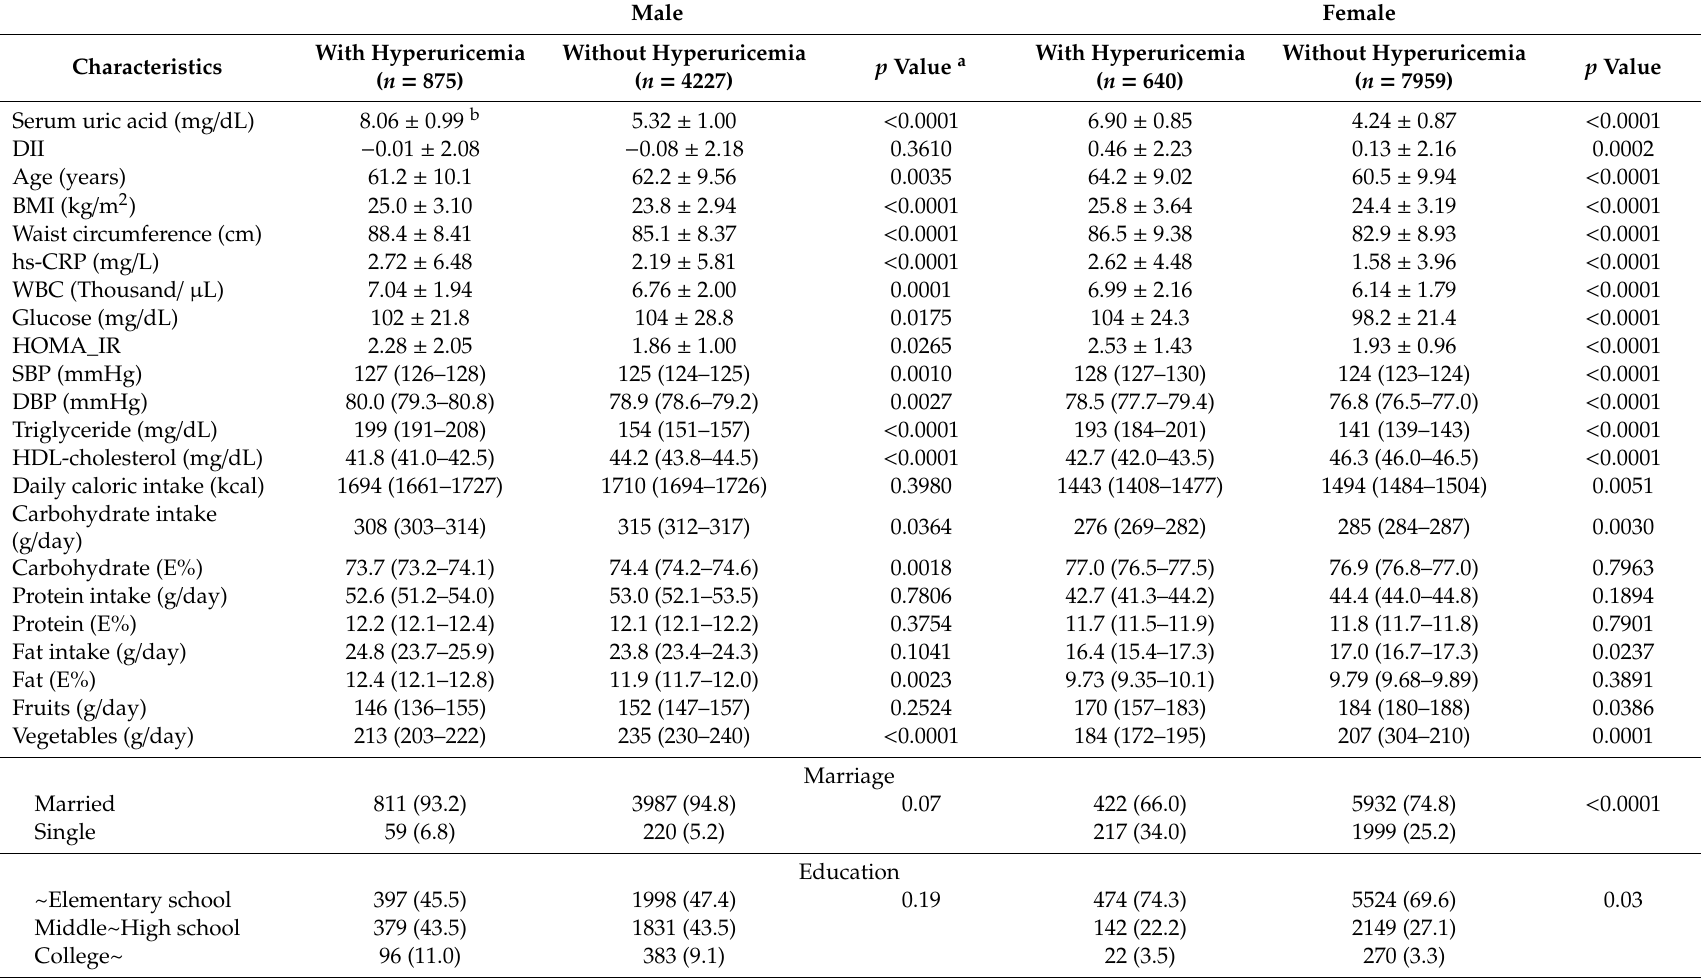
Table 1. Characteristics of study participants in KoGES_CAVAS